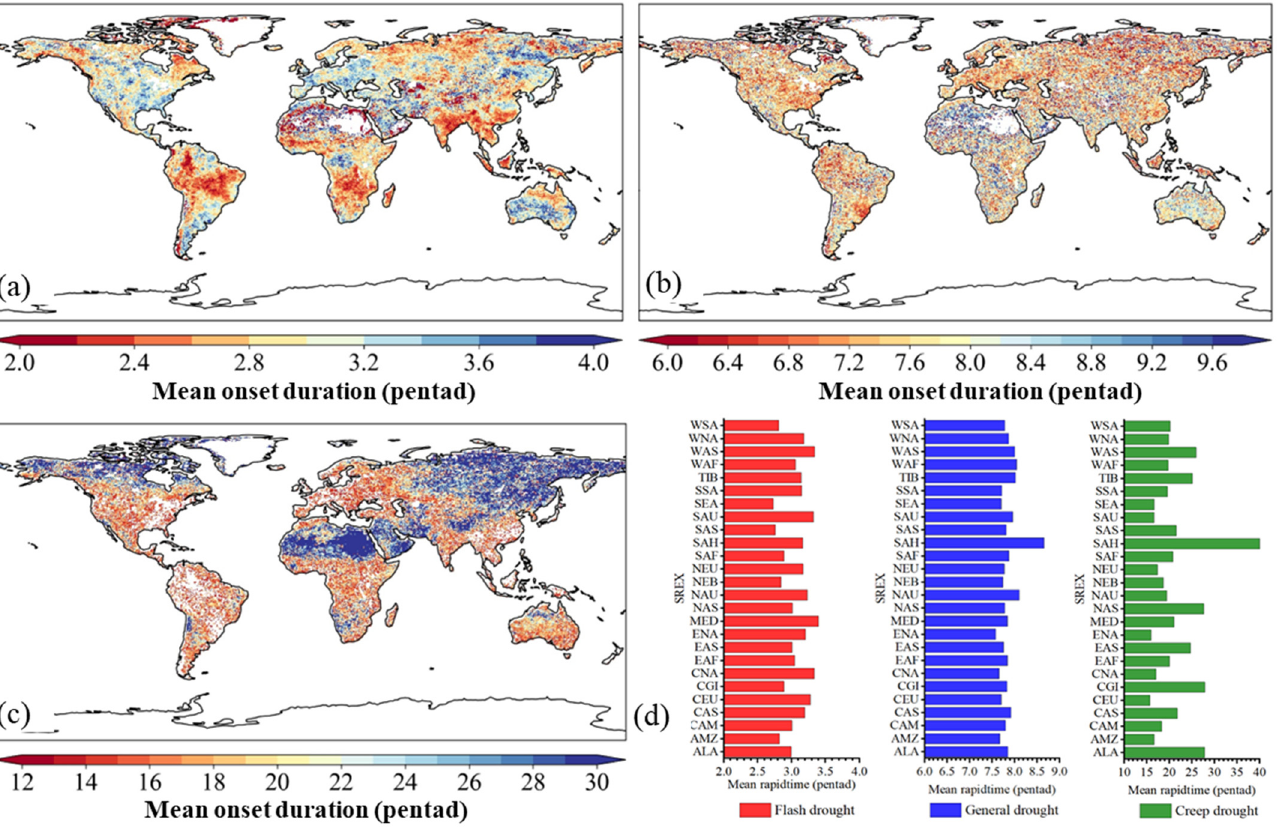
Figure 6. Spatial distribution of mean onset duration of flash drought ( a ), general drought ( b ), and creep drought ( c ), and the comparison of mean onset duration on a regional scale ( d ).